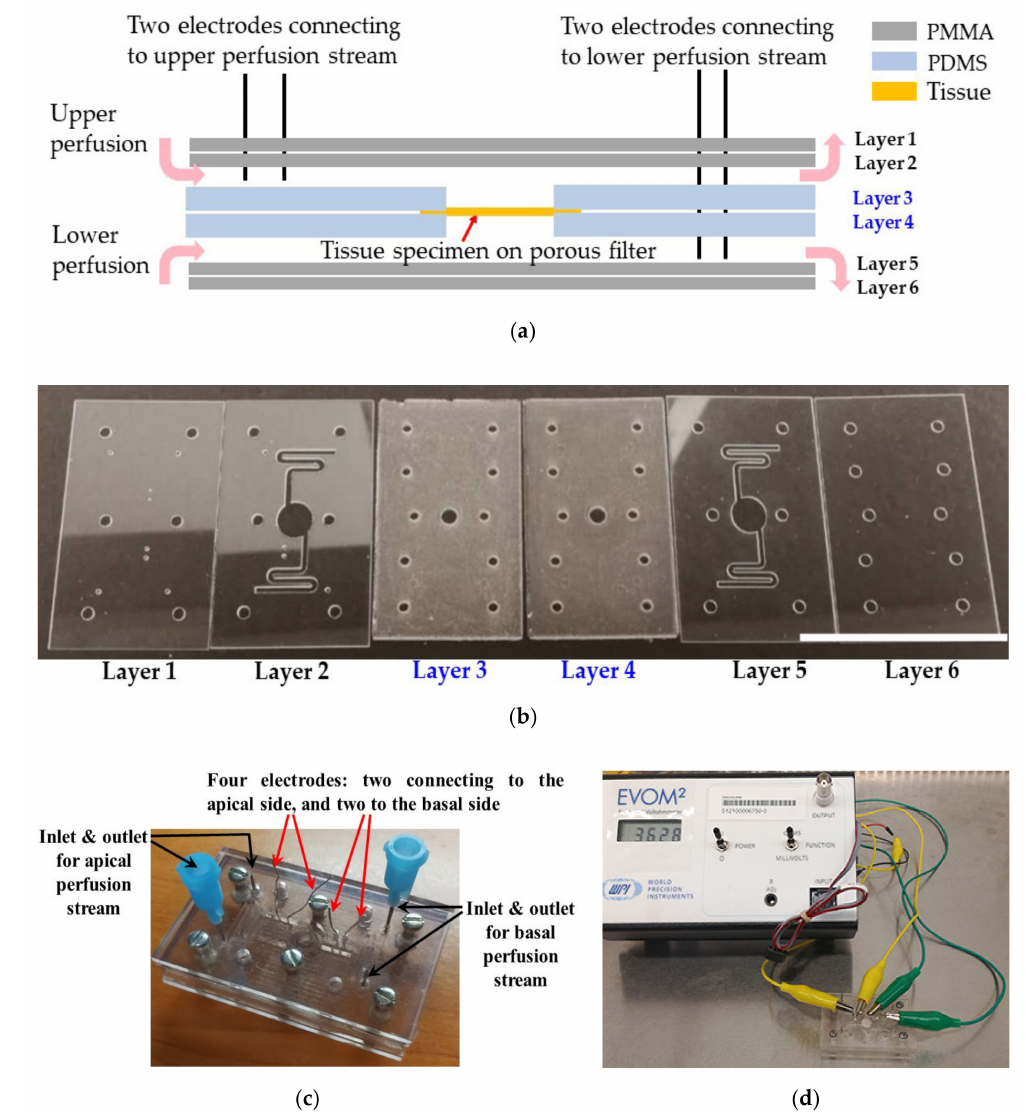
Figure 4. Design concept and experimental setup of our dual-function tissue biochip: ( a ) Cross-sectional view of the biochip structure; ( b ) Image of all the six component layers that constitute the biochip. Layers 1 and 2 provide the upper perfusion channel; Layers 3 and 4 form the tissue loading layers, and Layer 5 and 6 make up the lower perfusion channel. The scale bar represents 5 cm. ( c ) Final assembled biochip (5.5 cm × 3.5 cm). Two perfusion flows were supplied to preserve the tissue specimen in the chip using a peristaltic pump at flow rate of 0.6 mL / h from a KGM medium reservoir maintained in an incubator at 37 ◦ C and 5% CO 2 . ( d ) TEER measuring